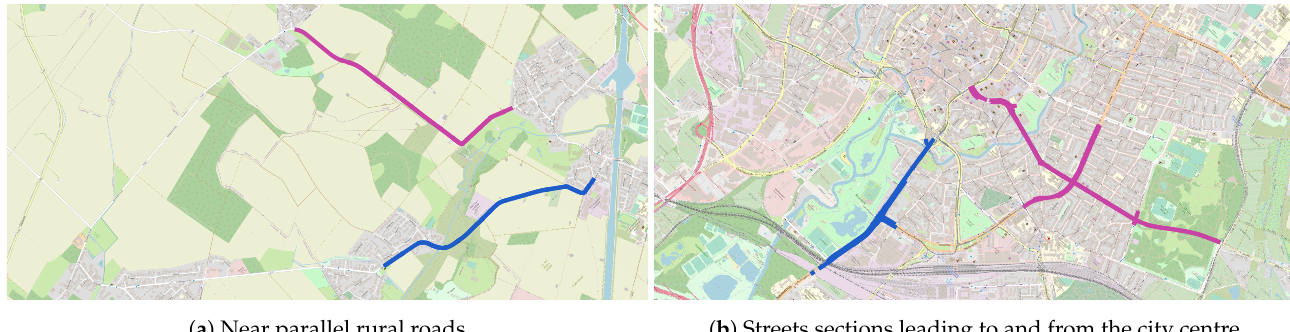
Figure 5. Examples of identified dependencies between subgraphs in Brunswick. Dependent subgraphs are marked in blue and purple. Map images: c (cid:13) OpenStreetMap contributors, ODbL.